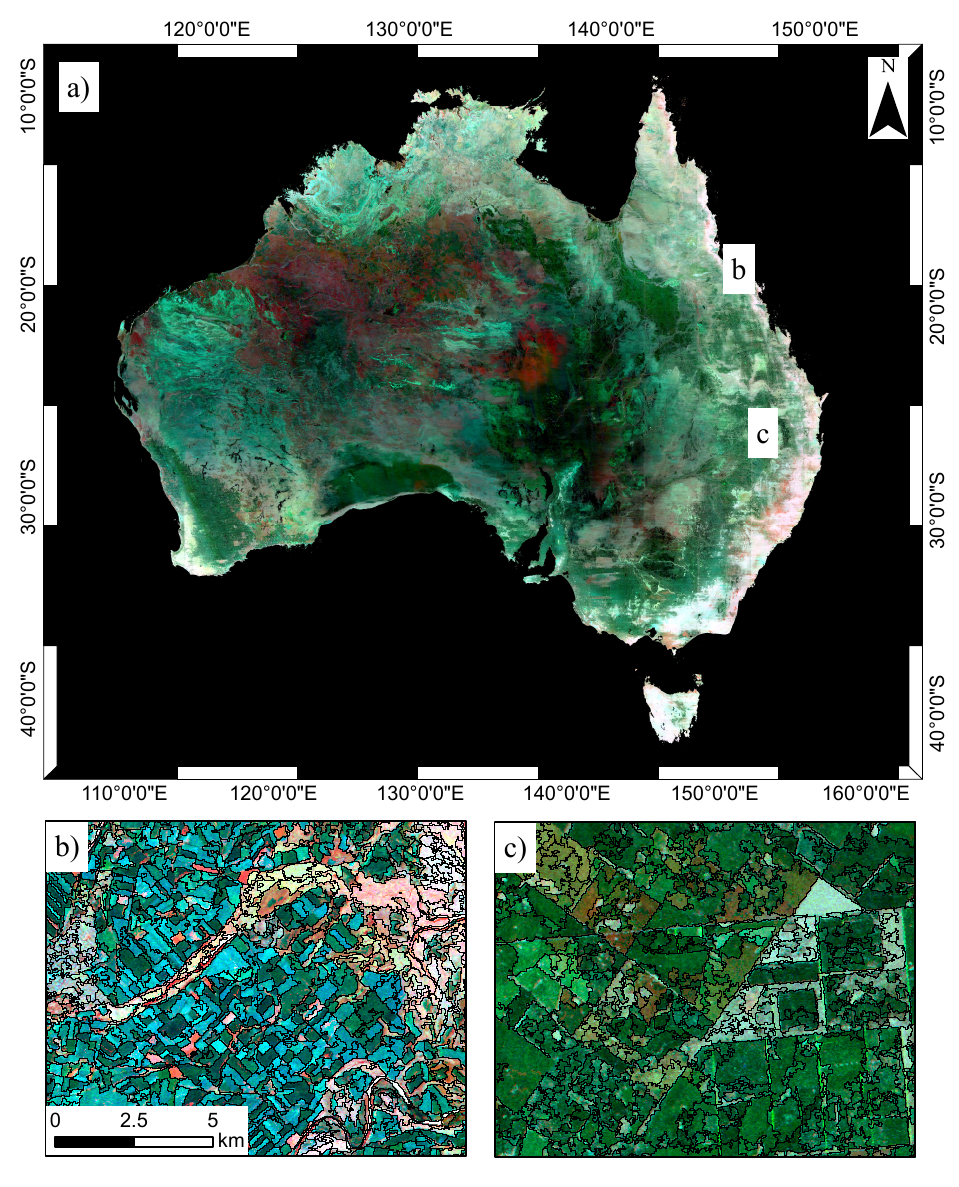
Figure 9. A national-scale segmentation of Australia derived from a composite of persistent green fraction [34] and Advanced Land Orbiting Satellite (ALOS) PALSAR data with a spatial resolution of 30 m. ( a ) Overview of the entire segmentation with each object coloured using the mean persistent green fraction product (red), and ALOS PALSAR HH (green) and HV (blue) backscatter. Subsets ( b,c ) show the objects in detail over-persistent green fraction and PALSAR